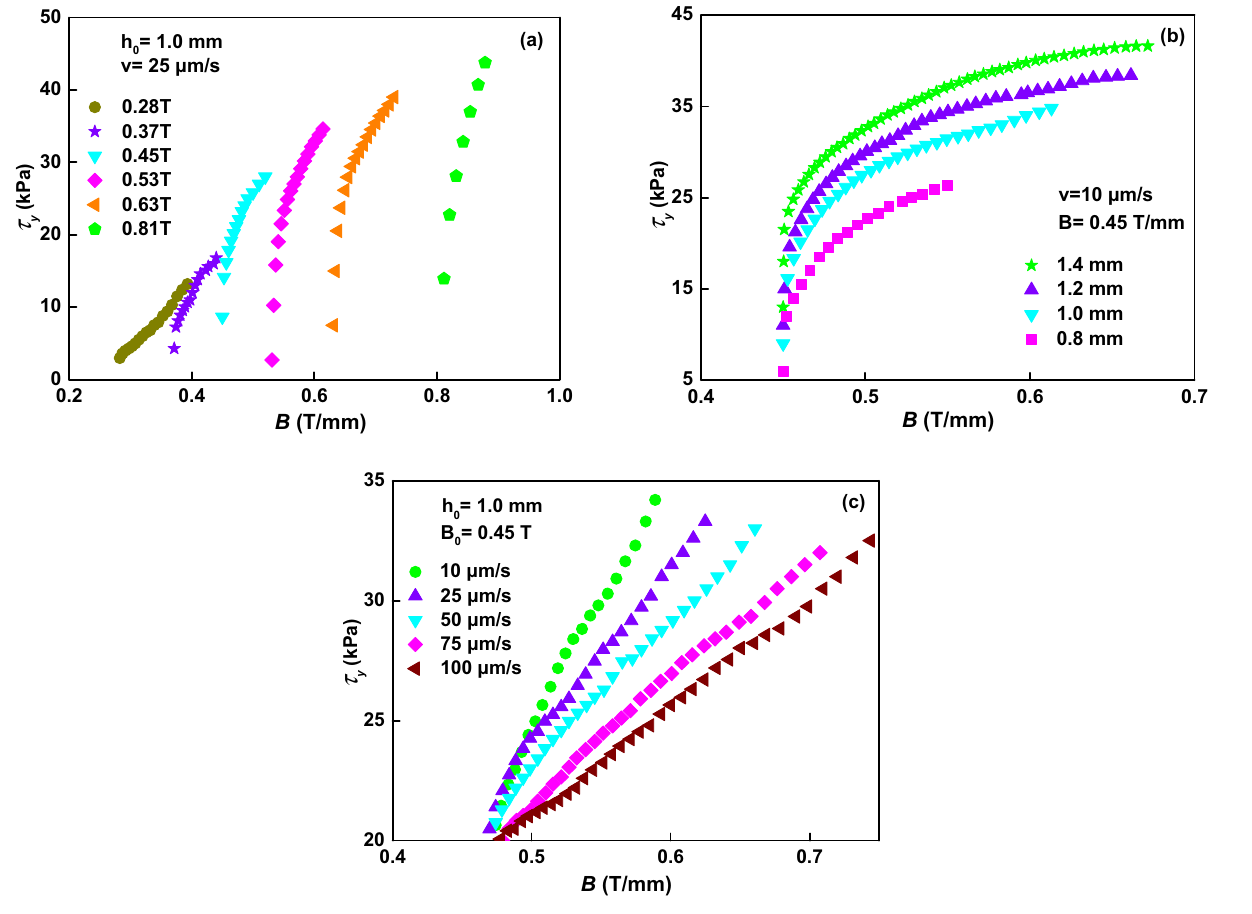
Figure 6. Nominal yield shear stress versus B . ( a ) at h 0 =1.0 mm v = 25 μm/s under different magnetic fields. ( b ) at B 0 = 0.45 T v = 10 μm/s under different original gap distances. ( c ) at B 0 = 0.45 T and h 0 =1.0 mm under different compressive